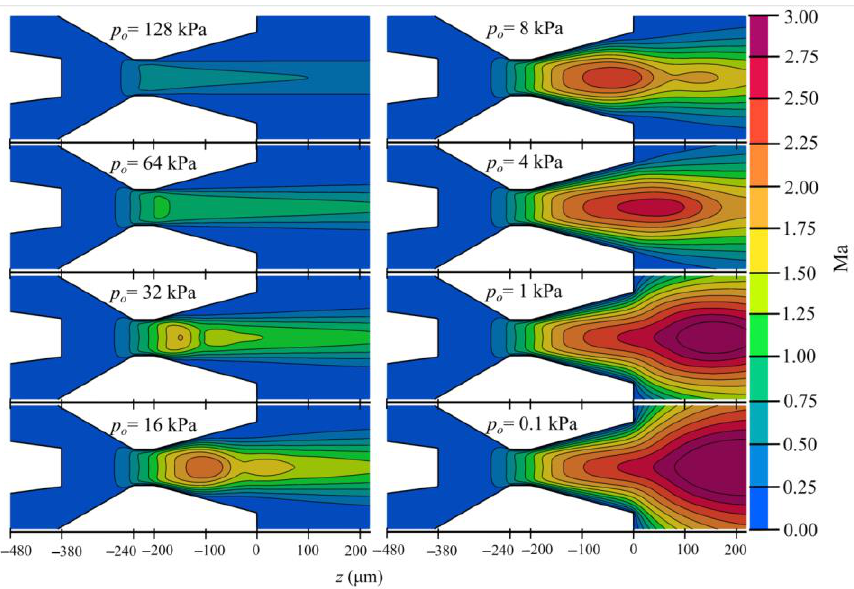
Figure 3. Mach number contours of the gas flow inside a nozzle with L d = 200 µm and θ d = 15 o , for different outlet chamber pressures.